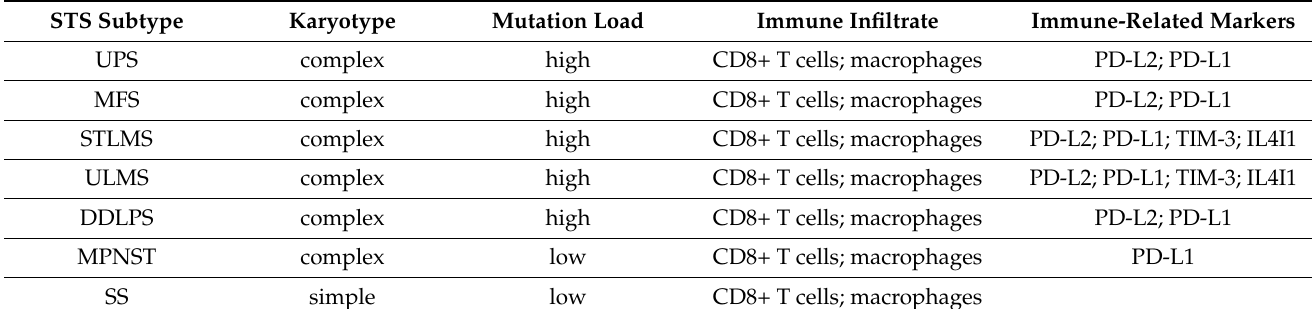
Table 1. Summary of karyotype, mutational load, immune infiltrate, and immune-related marker findings for the different sarcoma